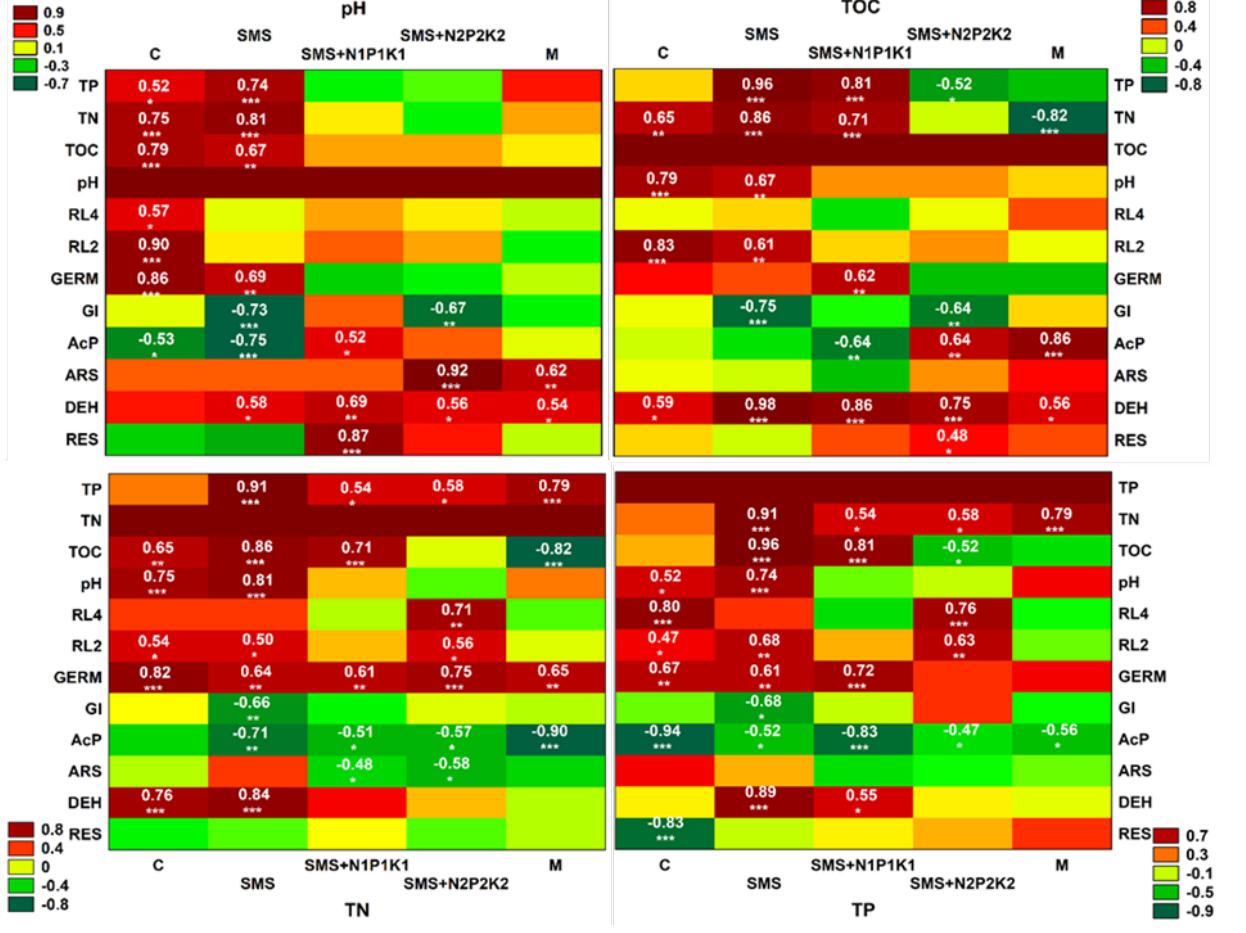
Figure 13. Heat map displaying the Pearson correlation coefficients between chemical and physico-chemical properties; biochemical and enzymatic activity; and phytotoxic parameters at the combination level. Significance noted at * p < 0.05; ** p < 0.01; and *** p < 0.001, respectively.